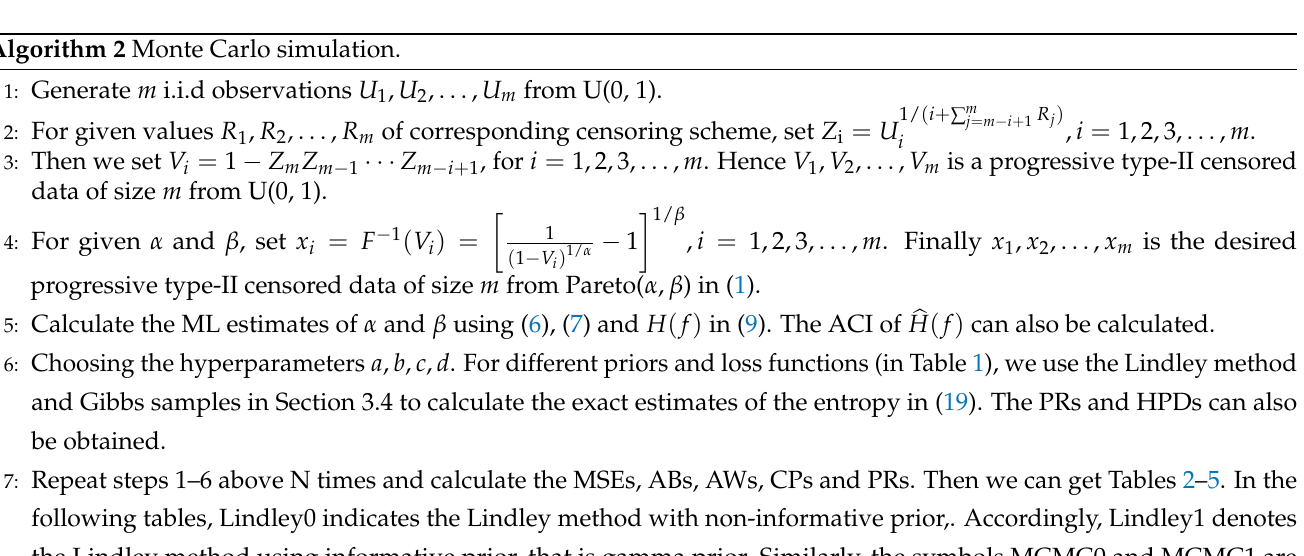
Algorithm 2 Monte Carlo